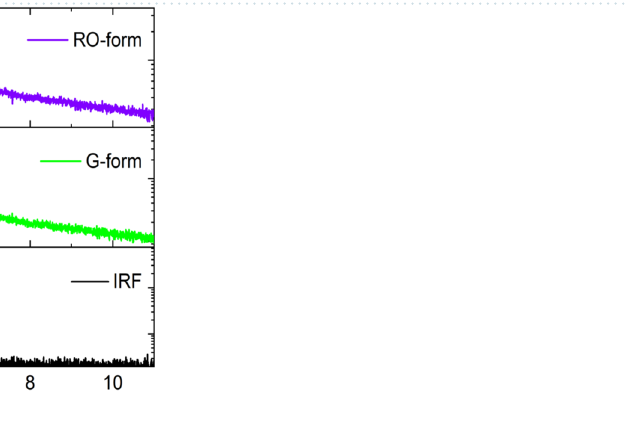
Figure 9. FL emission decay profiles of DSP crystals in G- and